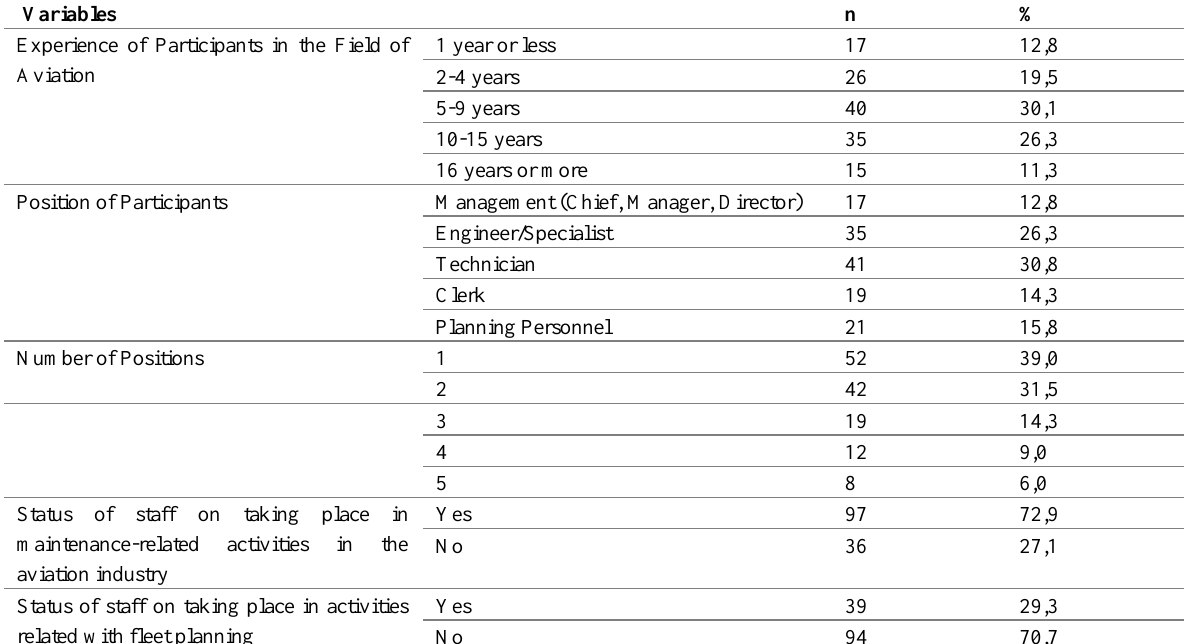
Table 3: Findings on the Experience of Participants in the Area of